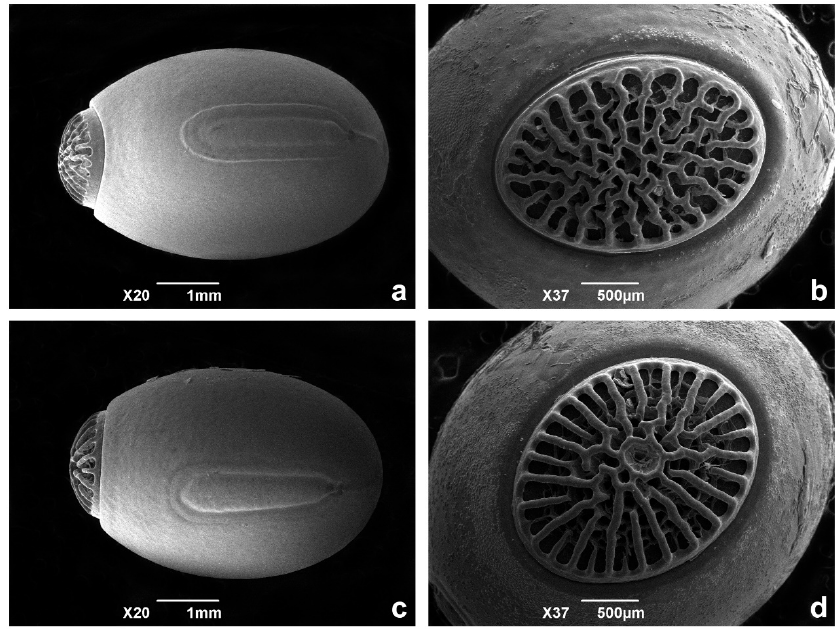
Figure 6. General aspect of the eggs under scanning electron microscopy. ( a , b ) Cladomorphus petropolisensis ; ( c , d ) C. phyllinus.